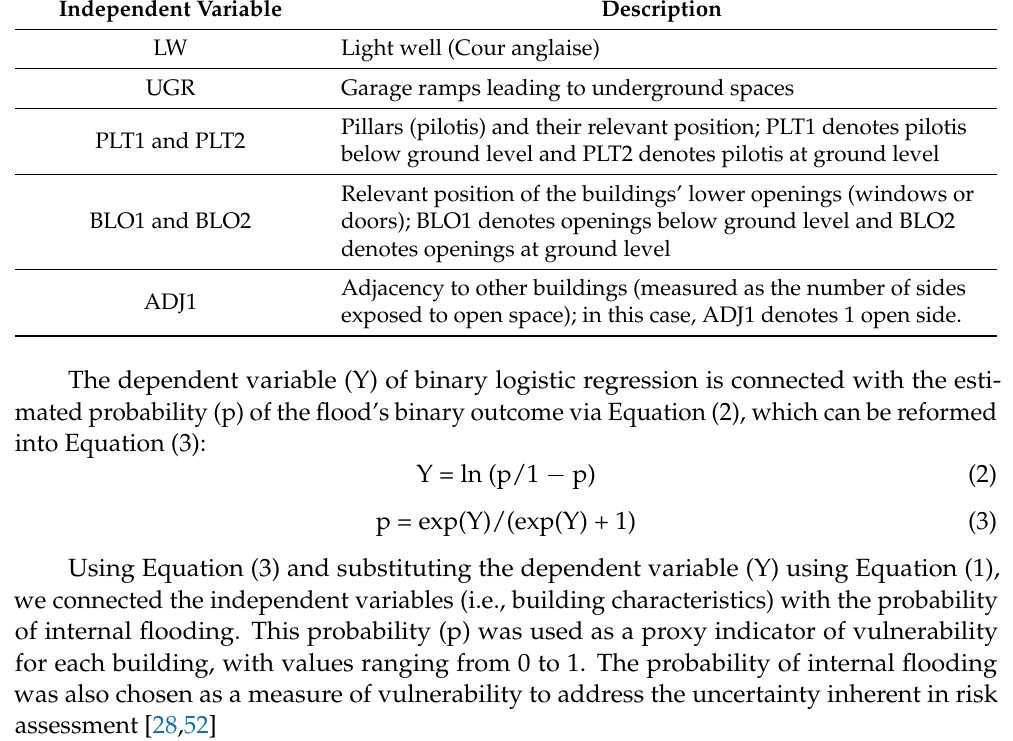
Table 4. Description of independent variables representing building characteristics. Independent Variable Description LW Light well (Cour anglaise) UGR Garage ramps leading to underground spaces Pillars (pilotis) and their relevant position; PLT1 denotes pilotis PLT1 and PLT2 below ground level and PLT2 denotes pilotis at ground level Relevant position of the buildings’ lower openings (windows or BLO1 and BLO2 doors); BLO1 denotes openings below ground level and BLO2 denotes openings at ground level Adjacency to other buildings (measured as the number of sides ADJ1 exposed to open space); in this case, ADJ1 denotes 1 open side.